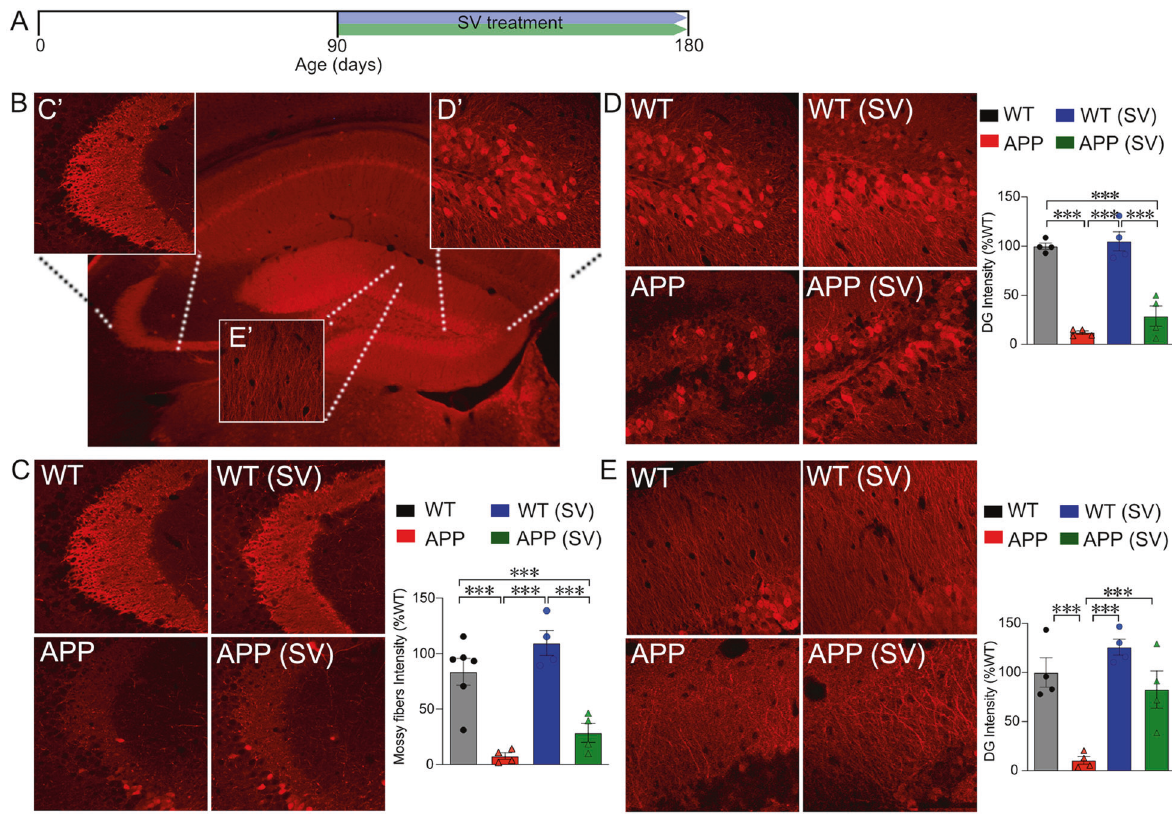
Fig. 3 SV restored dendritic extensions of calbindin-immunolabelled mature granule cells in the dentate gyrus molecular layer in APP mice. A Schematic representation of experimental design and timeline of SV treatment. B A confocal image of calbindin-immunostained mature granule cells with their axonal projections through the mossy fi bers in the CA3 area (C ’ ), cell bodies at the level of the dentate gyrus apex area (DG, D ’ ), and their dendritic arborizations in the molecular layer (E ’ ). Quantitative analysis revealed dramatic decreases in the intensity of calbindin-immunostained mossy fi bers ( C ) and cell bodies ( D ) in APP mice compared to WT controls, de fi cits that were not improved by SV treatment. In contrast, the drastic decrease in calbindin-immunostained dendritic extensions in the DG molecular layer was normalized to control levels in APP mice treated with SV ( E ). *** p < 0.001, using two-way ANOVA followed by Newman – Keuls post-hoc